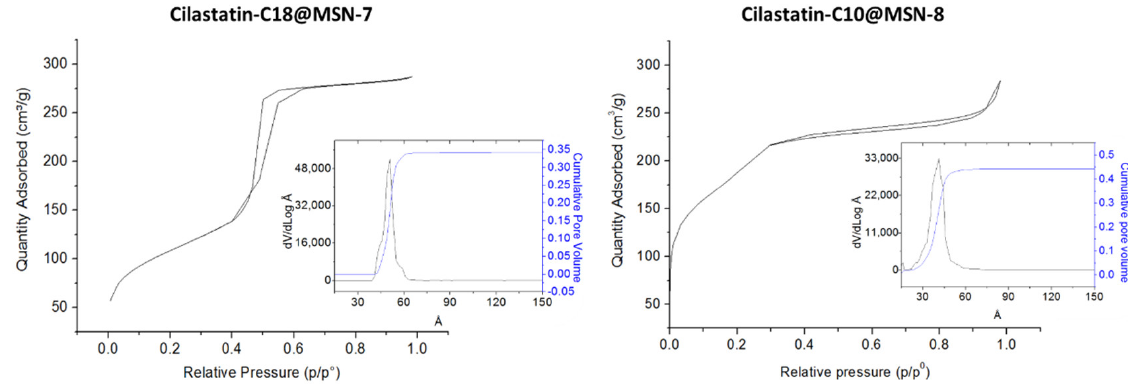
Figure 4. N 2 adsorption–desorption isotherms and pore size distributions (PSD) based on a NLDFT model of Cilastatin-C18@MSN-7 and Cilastatin-C10@MSN-8. The synthesized cilastatin-C18@MSNs and cilastatin-C10@MSNs were also 3.3. Release Experiments of Mesoporous Silica Nanoparticles with DSDAs of Cilastatin (cilastatin@MSNs).